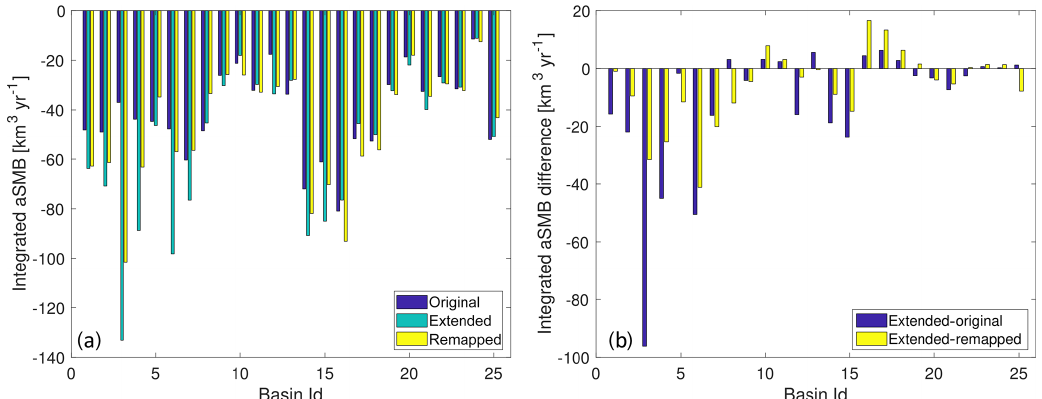
Figure 8. Remapping results for a model state far from the observed geometry. (a) Integrated aSMB per basin from MAR model output on the observed ice mask (blue) for extension of the VUB_GISM model ice mask (green) and remapped to the VUB_GISM model geometry (yellow). (b) Extended − original (blue) and extended − remapped (yellow).